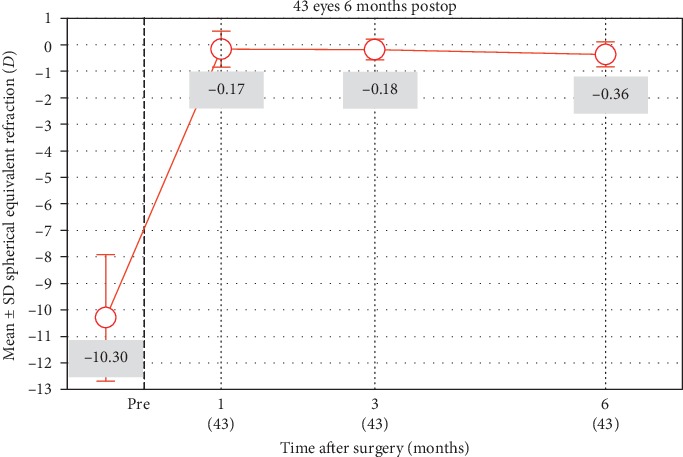
Stability of spherical equivalent refraction.